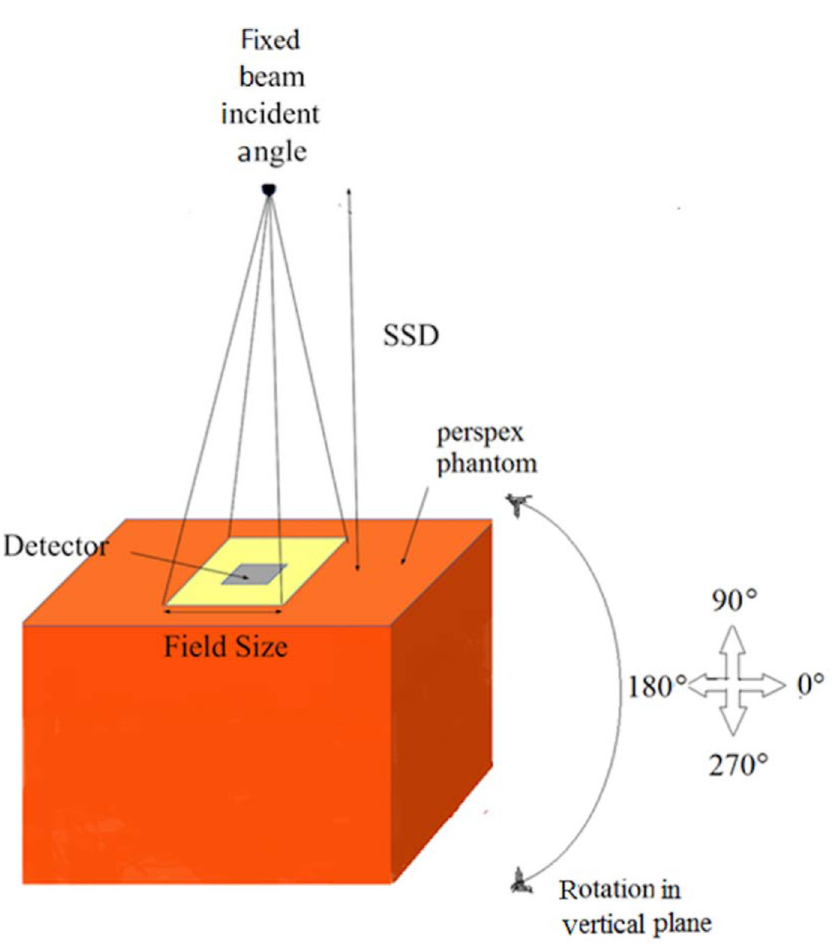
Fig 5. Schematic illustrations of the setup for the angular dependency study. The position of the detector and the irradiator is shown in the fig. doi:10.1371/journal.pone.0153913.g005 PLOS ONE | DOI:10.1371/journal.pone.0153913 May 5,